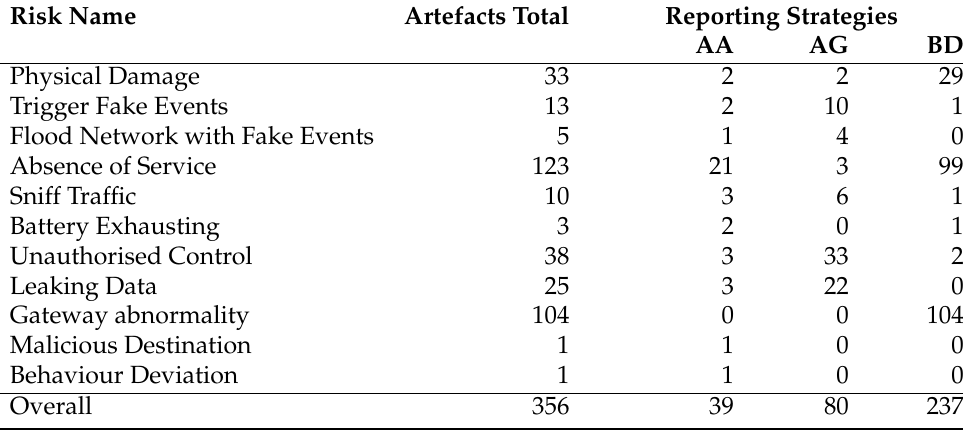
Table 11. Risks and Artefacts per RS